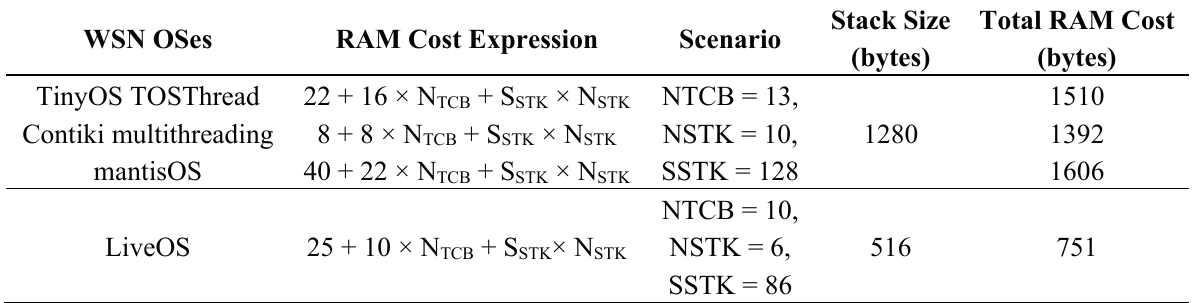
Table 1. Data memory cost of different multithreaded WSN